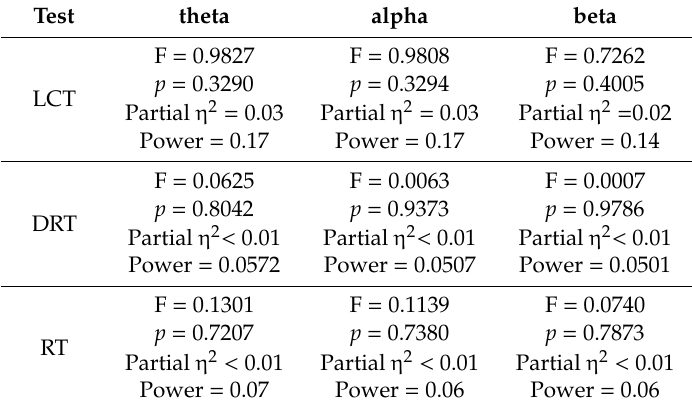
Results from the one-way multivariate analysis of variance (MANOVA) with repeated-measurement design of power spectrum density (PSD) data of electroencephalograph (EEG)